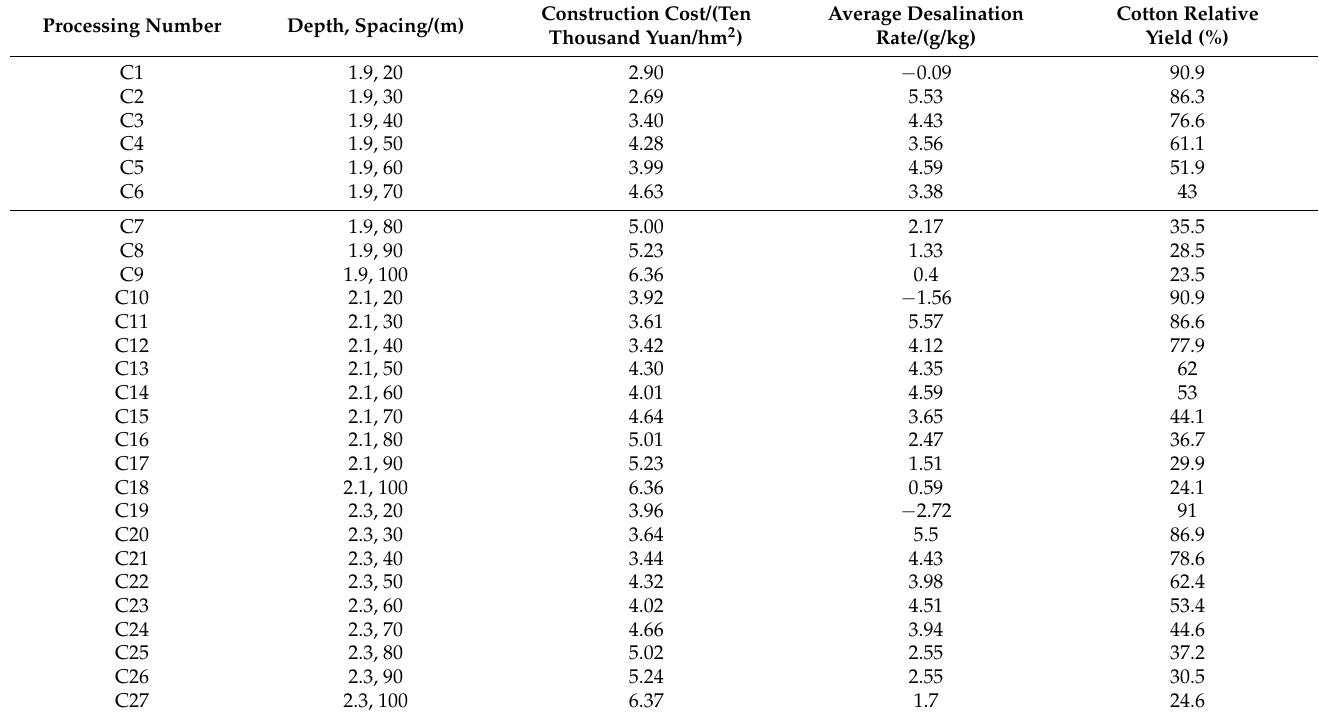
Table 6. Simulation statistics of the soil desalination effect for the 27 pipe drainage measures.